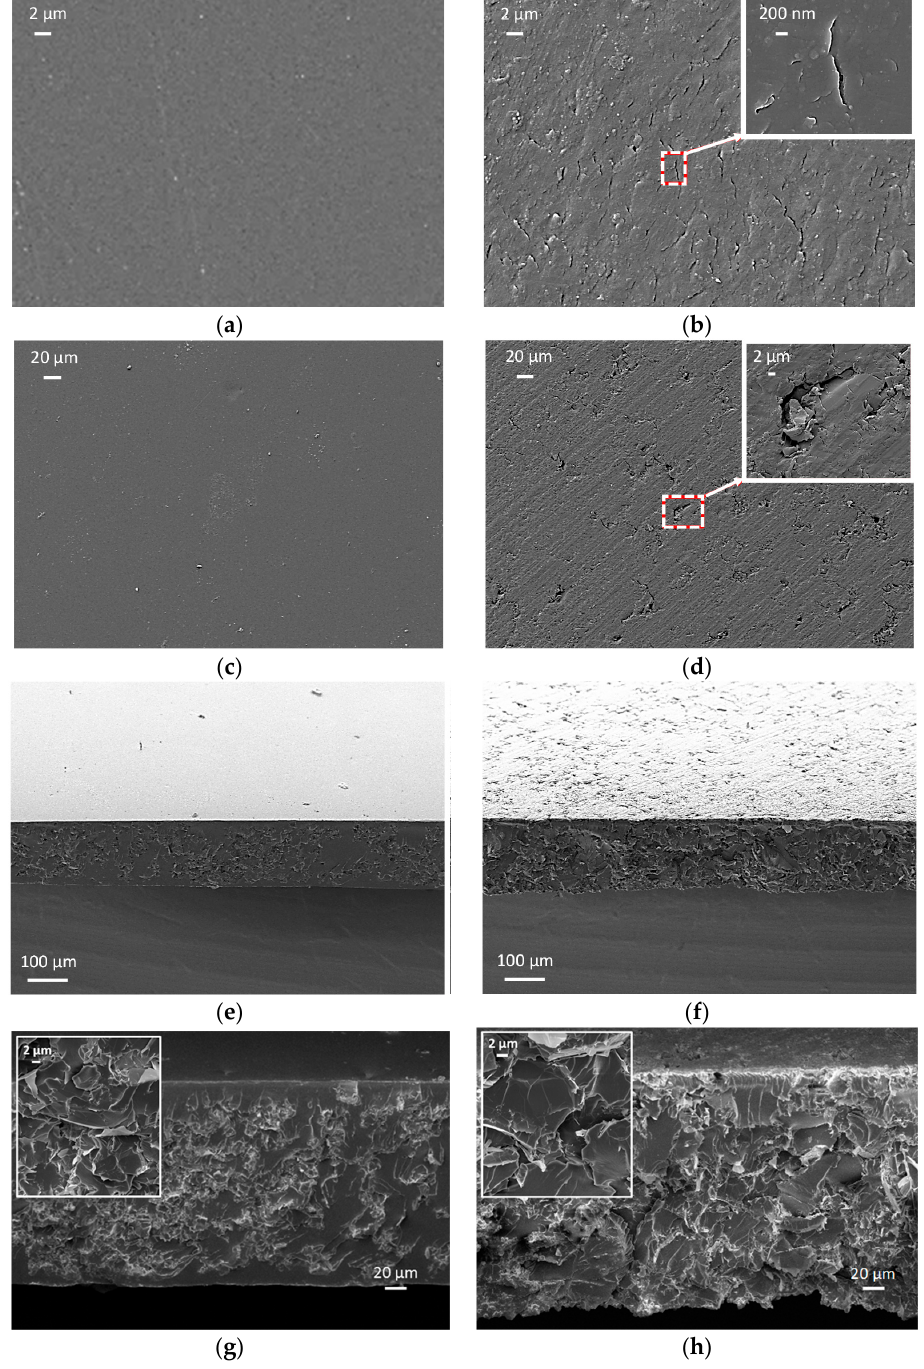
Figure 6. Top views of: vinyl ester lamina produced via ( a ) the capillary rise method or ( b ) the resin casting method; MLG-composite lamina produced via ( c ) the capillary method or ( d ) the resin casting method. Cross-section views of: MLG-composite lamina obtained via ( e ) the capillary method or ( f ) the resin casting method. High magnification and zoomed areas of the cross-section of MLG-composite lamina obtained via ( g ) the capillary method or ( h ) the resin casting method.